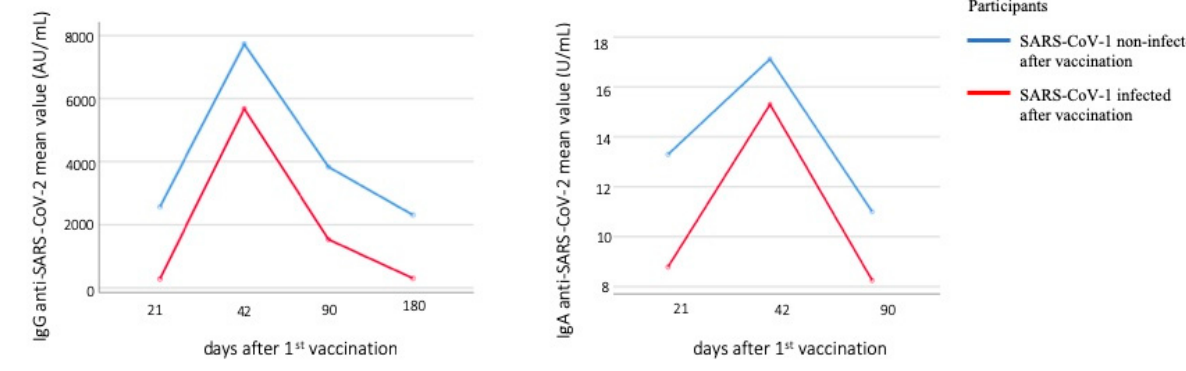
Figure 3. Line chart of anti-S IgG and IgA antibodies levels between infected and noninfected with SARS-CoV-2 after vaccination individuals.